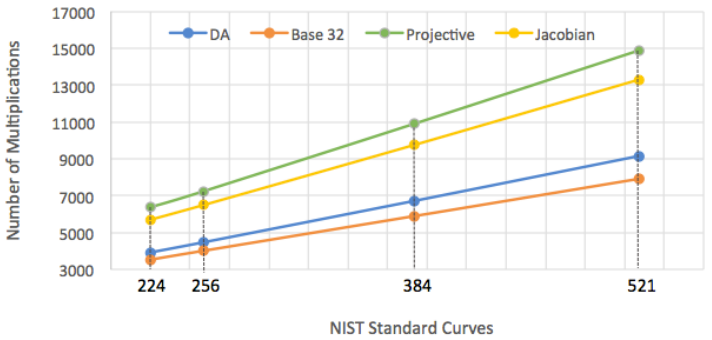
Figure 5. Our Work vs. Other Coordinates Algorithms in Terms of Number of Multiplications.